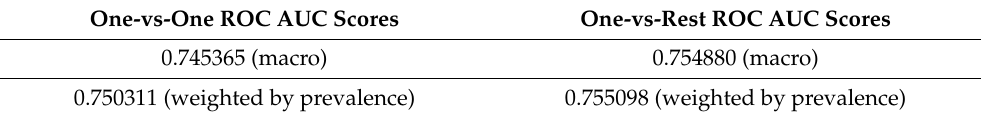
Table 4. ROC AUC scores.